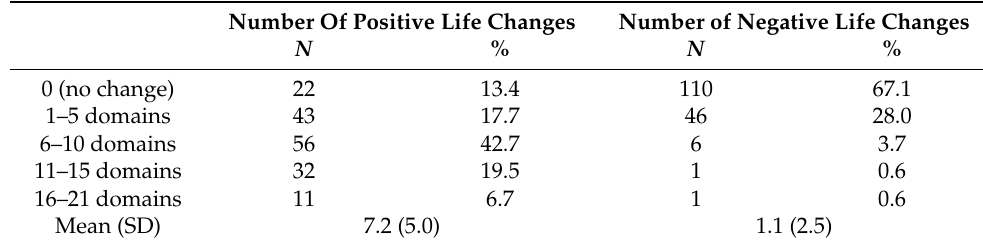
Table 2. Number of perceived positive and negative life changes for 21 life domains ( N = 164).